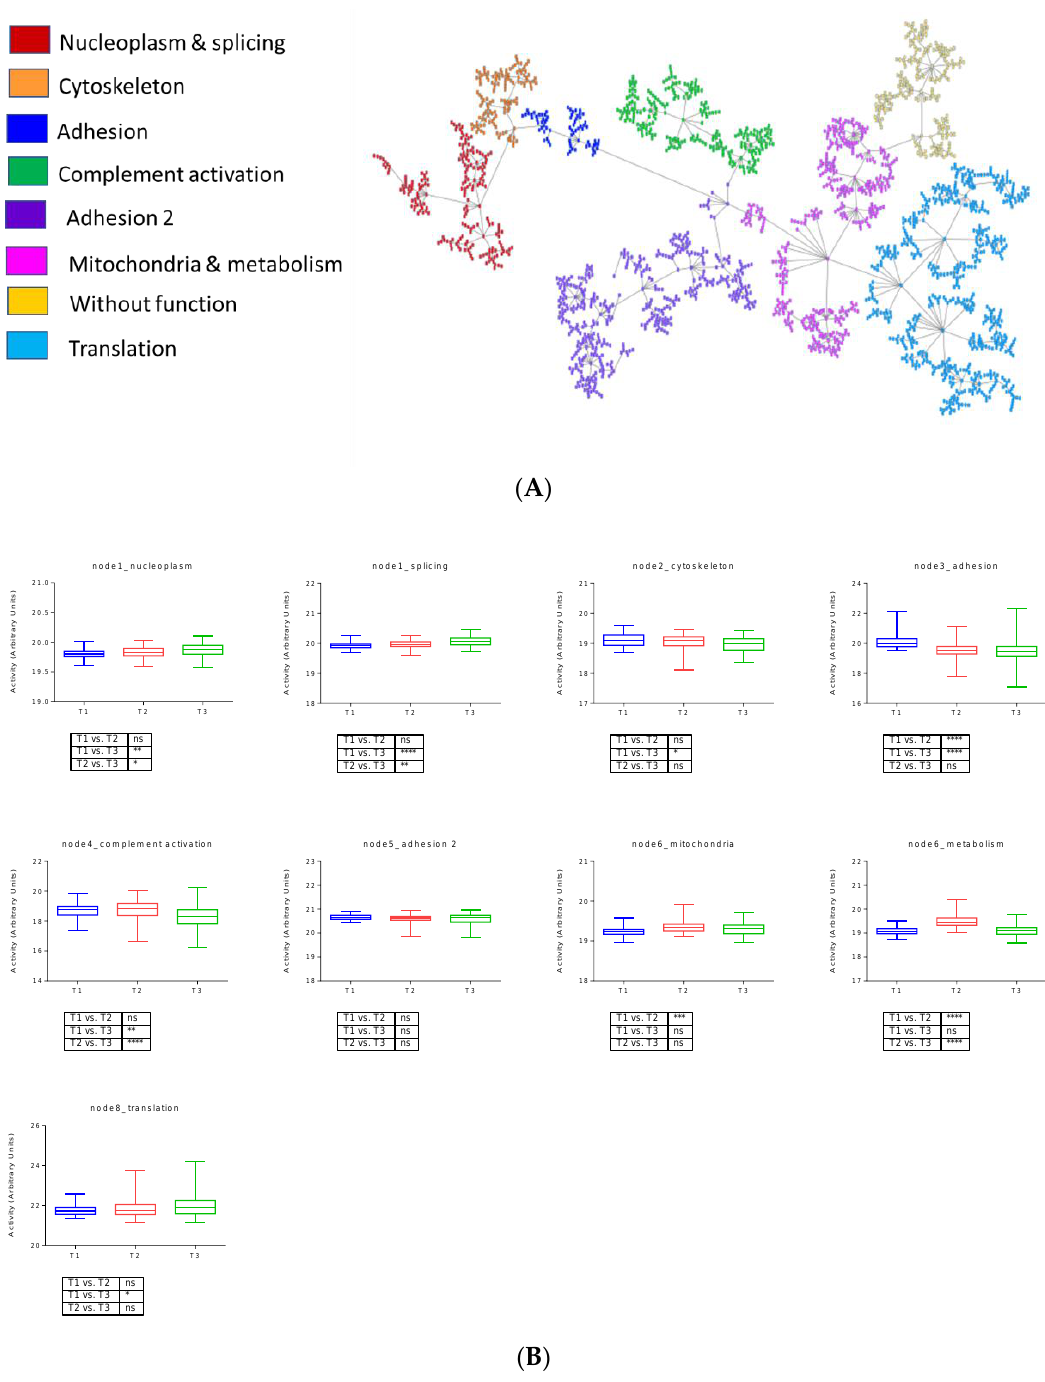
Figure 2. ( A ) Network formed by 2311 proteins in PDAC tumor samples. ( B ) Functional node activi- ties comparing the three proteomic subtypes in tumor samples. **** p < 0.0001; *** 0.0001 < p < 0.001; ** 0.001 < p < 0.05. * p < 0.05; ns: nucleoplasm subtype. Regarding the clinical relevance of these subtypes, T1 and T2 contained most of the pancreatic tumors located in the head of the pancreas, and T3 contained most of the tumors located in the body and tail (Supplementary Figure S1A). There were no significant differences between T groups according to age, gender, diabetes, pancreatitis, smoking, grade, type of resection, pT, pN, stage, or location of metastases. Any differences in prognosis according to overall survival or disease-free survival between the three